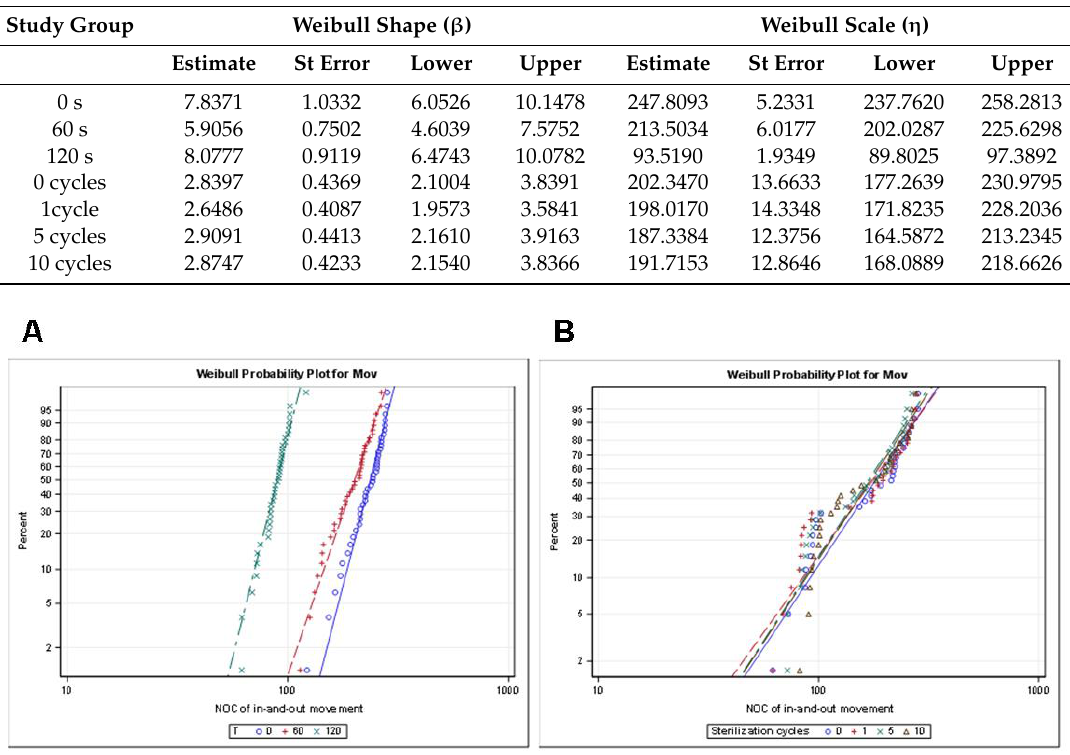
Figure 8. ( A ) Weibull probability plot of the number of cycles of in-and-out movements for the time of use and ( B ) sterilization cycles study groups.